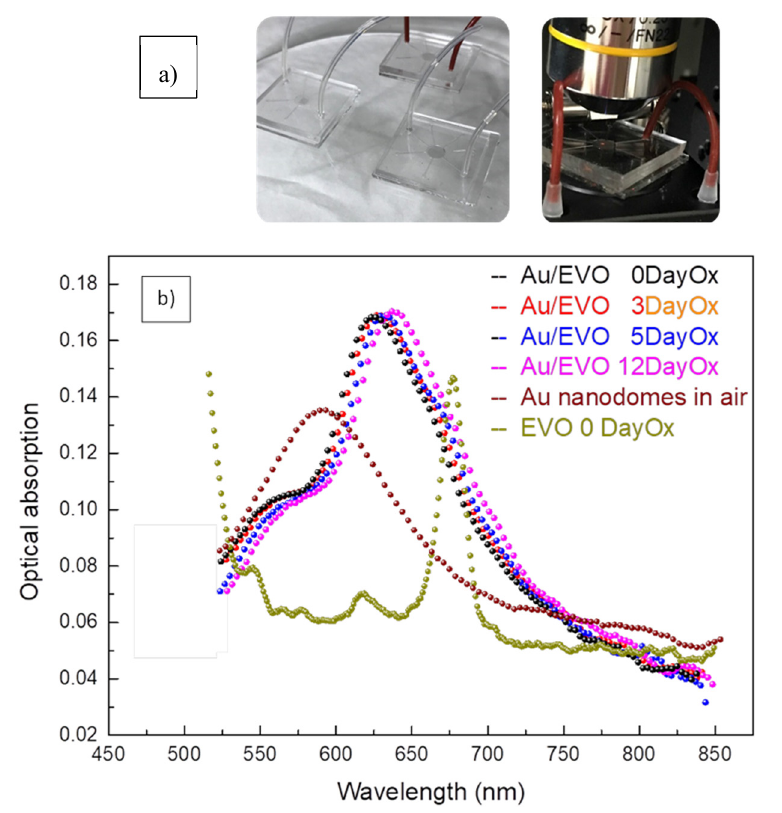
Figure 5. ( a ) Experimental set-up and microfluidic chips used during the experimental optical measurements ( b ) Optical absorption measurements in the UV-VIS spectral range performed on EVO oil at different oxidation states. Optical absorption of the nanodomes’ array in dry air and of the EVO oil are reported.